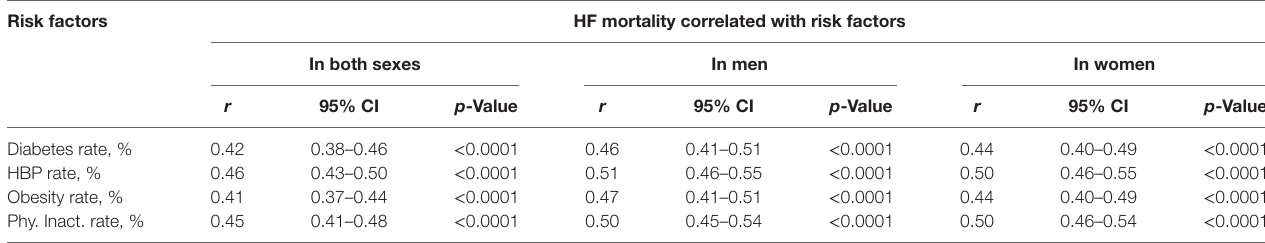
TaBle 3 | Correlation coefficients ( r and 95% CI) between risk factors and HF mortality. risk factors hF mortality correlated with risk factors in both sexes